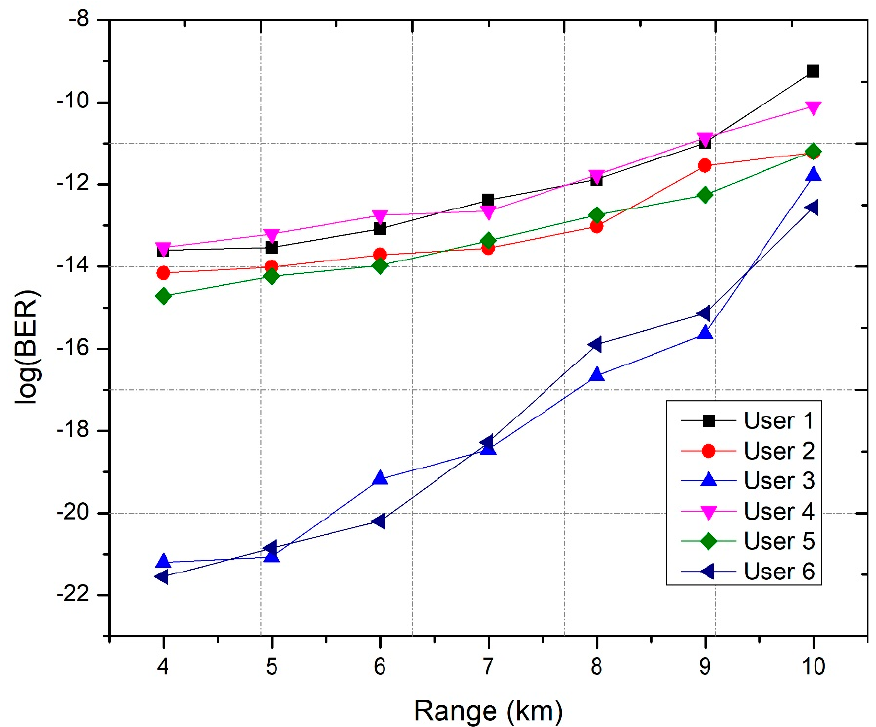
Figure 3. log(BER) for PDM-SAC-OCDMA-enabled FSO transmission under CW versus range.